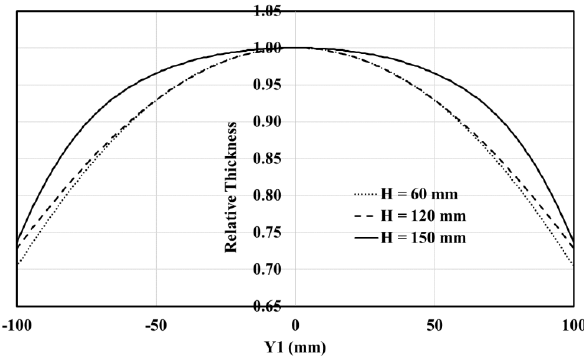
Figure 17. Relative film thickness distribution at different Y 1 positions.